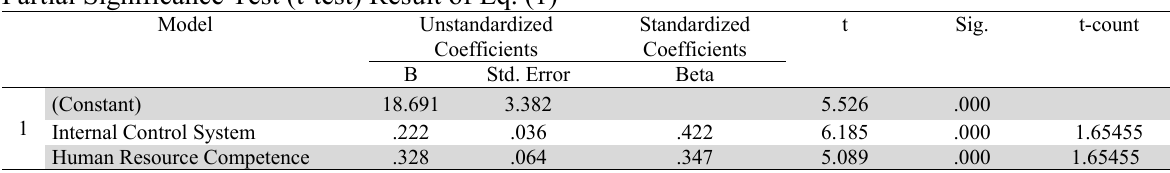
Partial Significance Test (t-test) Result of Eq. (1)